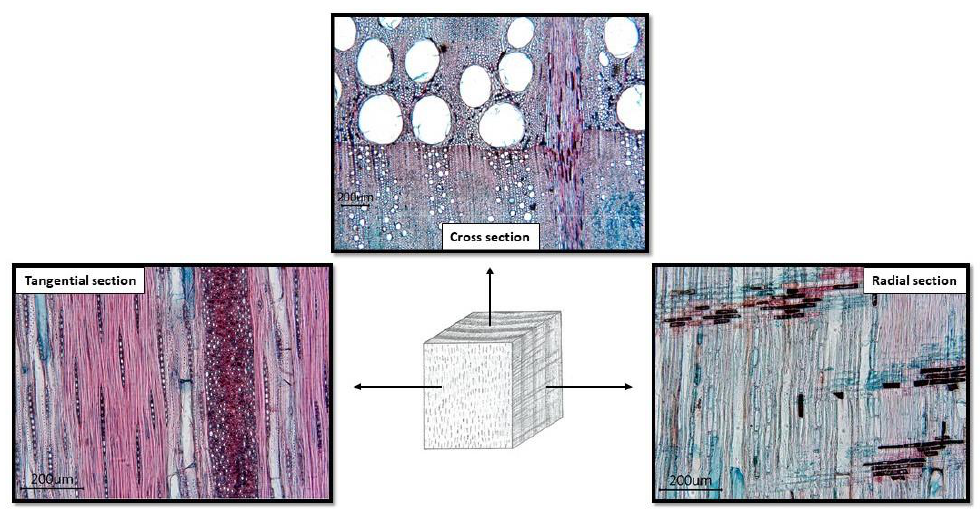
Figure 2. Oak microstructure in characteristic sections.